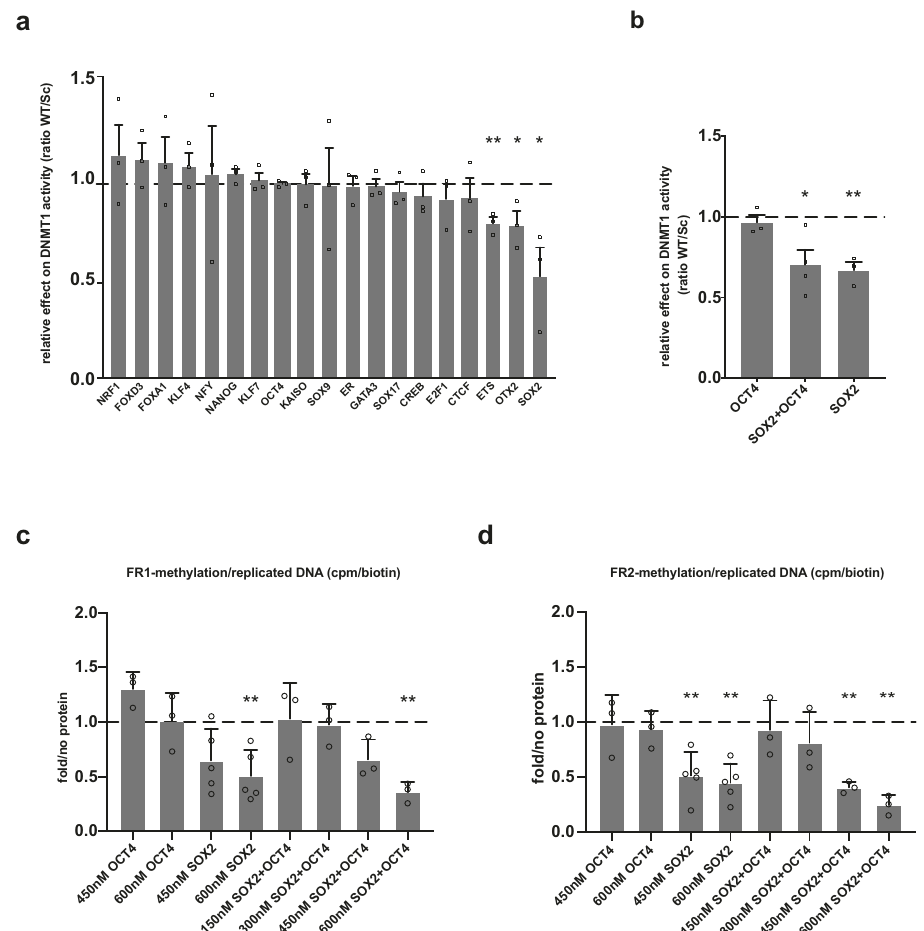
Fig. 7 SOX2 inhibits DNMT1-dependent maintenance of DNA methylation during replication. a In vitro methylation assay to measure DNMT1 methyltransferase activity using hemi-methylated probes containing WT or Sc PF motifs in the presence or absence of the corresponding PF. Relative DNMT1 activity is represented as scintillation counts in WT probes, corrected for the amount of recovered DNA probes and compared relative to the Sc probe. Results are shown as mean + SEM of n = 3 biologically independent replicates. SOX2, ETS1 and OTX2 signi fi cantly reduce DNMT1 activity. p values: ETS1 p = 0.0018, OTX2 p = 0.0238, SOX2 p = 0.026 (two-tailed unpaired t test; * p < 0.05, ** p < 0.01). b In vitro methylation assay using the probe containing the OCT4SOX2 motif in the presence of OCT4, SOX2 or SOX2 + OCT4 proteins. Results are shown as mean + SEM of n = 3 biologically independent replicates. p values: SOX2 + OCT4 p = 0.018, SOX2 p = 0.003, (two-tailed unpaired t test, * p < 0.05, ** p < 0.01). c , d In vitro replication assay to assess the effect of SOX2 and OCT4 binding on the maintenance of DNA methylation during replication. Two probes containing the OCT4SOX2 motif were used: FR1 ( c ) and FR2 ( d ). The indicated concentrations represent those of active hOCT4 and hSOX2 recombinant proteins that were used. Methylation levels following replication are measured based on the integration of radioactively labelled methyl group during replication and compared to “ no_protein ” control. Results are presented as mean + SD of n = 5 (hSOX2 samples) or n = 3 biologically independent replicates (hOCT4 and hOCT4 + hSOX2 samples) and analysed as radioactive signal in the presence of the protein relative to the signal in the absence of protein. p values: FR1_600nM_SOX2 p = 0.0092, FR1_600nM_OCT4 + SOX2 p = 0.0068, FR2_450nM_SOX2 p = 0.0071, FR2_600nM_SOX2 p = 0.0021, FR2_450nM_OCT4 + SOX2 p = 0.0026, FR2_600nM_OCT4 + SOX2 p = 0.0047 (two-tailed unpaired t test, ** p < 0.01). For all panels, source data are provided as a Source data fi